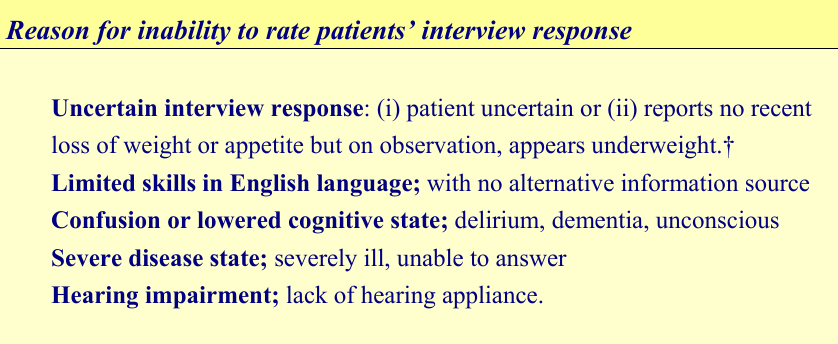
Table 2. Hierarchy of reasons for screened patients being rated in ‘unsure’ MST category